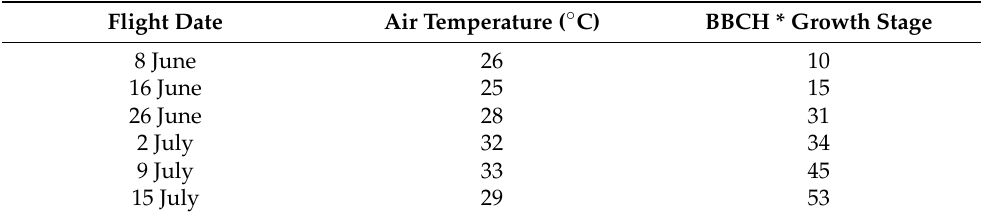
Table 1. Summary of Unmanned Aerial Vehicle (UAV) flight acquisitions with MicaSense RedEdge multispectral